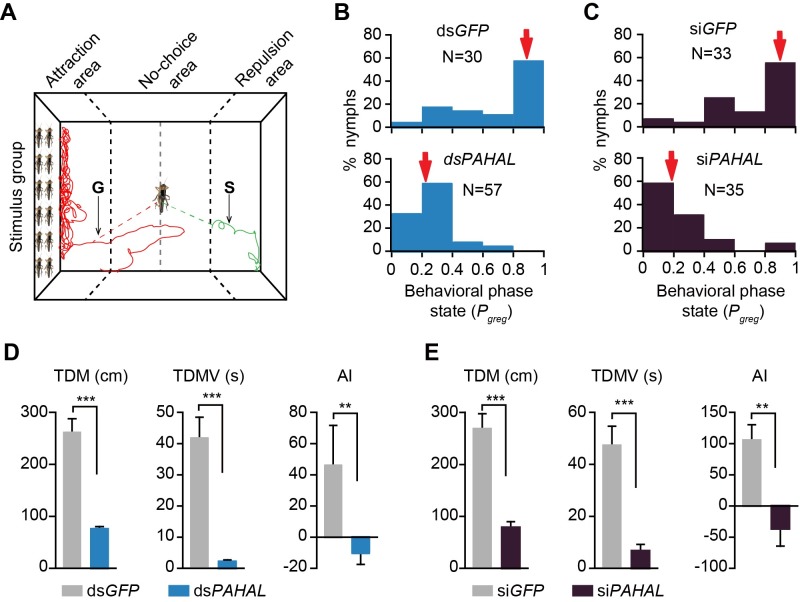
PAHAL modulates locust behavioural aggregation.(A) Movement trajectories of the G and S nymphs in the behavioural assay arena. A stimulus group of 30 G nymphs were placed behind a transparent porous partition on the left. (B) dsRNA interference of the PAHAL expression resulting in the behavioural transition from G to S phase. Pgreg is a measure of the predisposition of locusts to swarming, that is, 0 for typical solitarious behaviour and 1 for typical gregarious behaviour. Median Pgreg values are indicated by red arrows. (C) Behavioural changes resulting from siRNA interference of PAHAL. (D) dsRNA knockdown of the PAHAL expression altering behavioural traits, including the total distance moved (TDM), the total duration of movement (TDMV), and the attraction index (AI). (E) Behavioural traits affected by the siRNA knockdown of PAHAL. Asterisks indicate the significance level by Student’s t-test for TDM and TDMV and by Mann–Whitney U test for AI: **P < 0.01; ***P < 0.001.